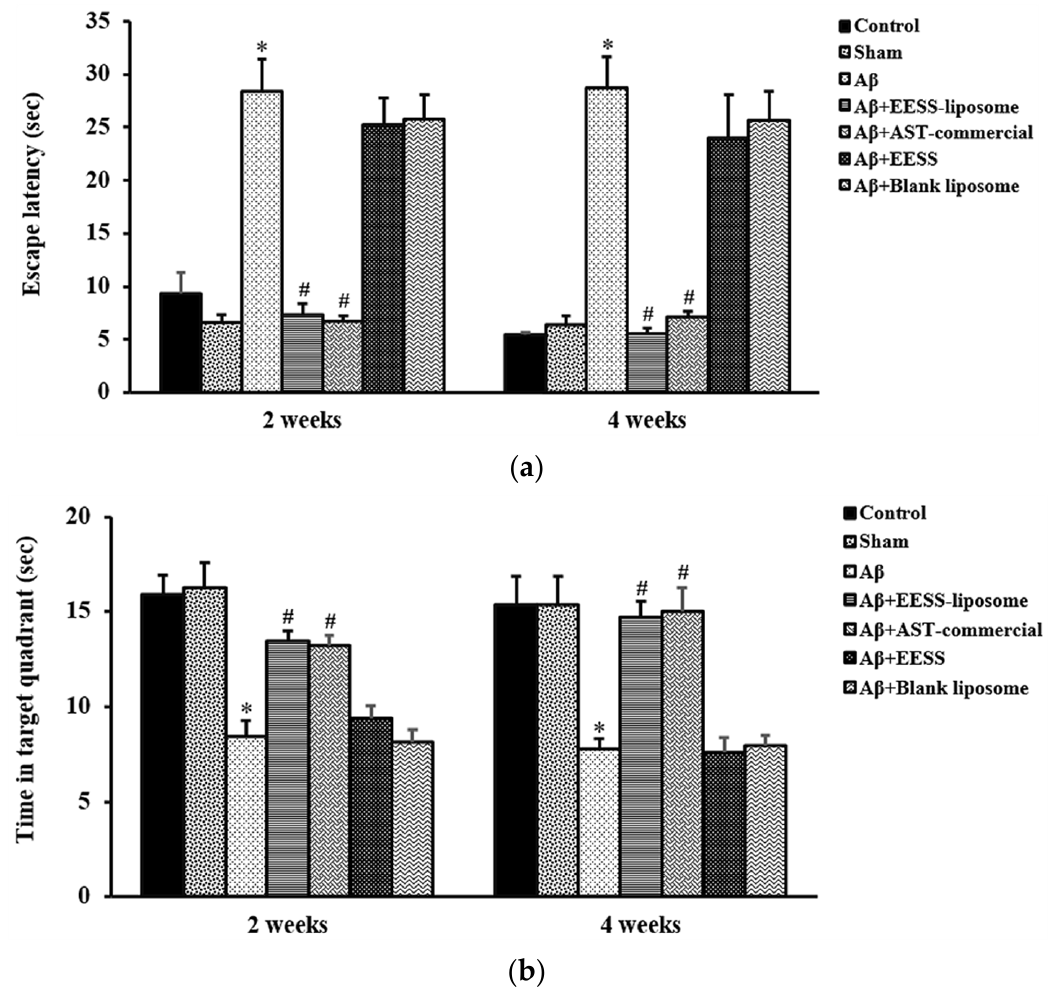
Figure 6. EESS-loaded liposome improved spatial memory in the MWT. ( a ) Escape latency (sec) at 2 and 4 weeks after A β infusion and ( b ) time in target quadrant (sec) at 2 and 4 weeks after A β infusion. Data were presented as means ± SEM. * indicates significant difference ( p < 0.05) between A β and sham groups; # indicates significant difference ( p < 0.05) between EESS-loaded liposome, AST-commercial and A β groups; n = 6 rats/group.